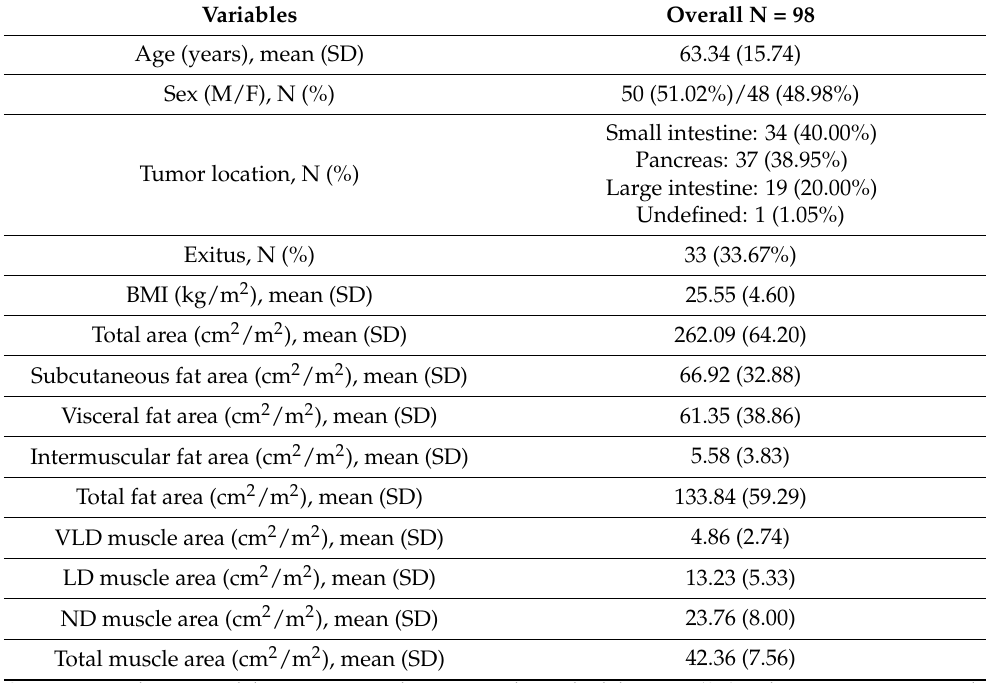
Table 1. Cohort description.